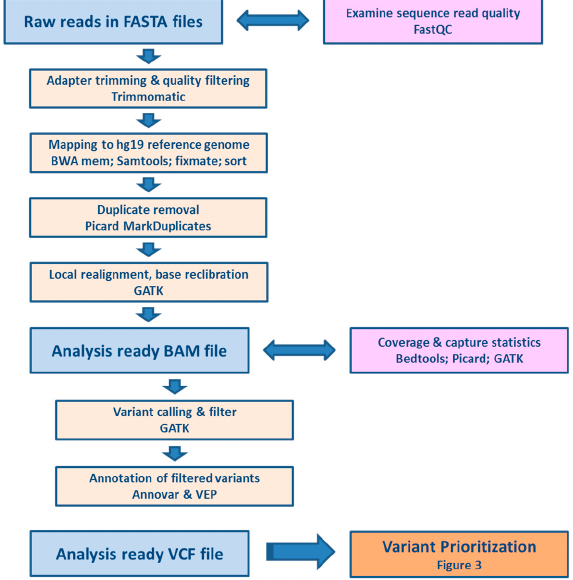
Figure 1. Pipeline for processing and quality control of raw sequencing data.